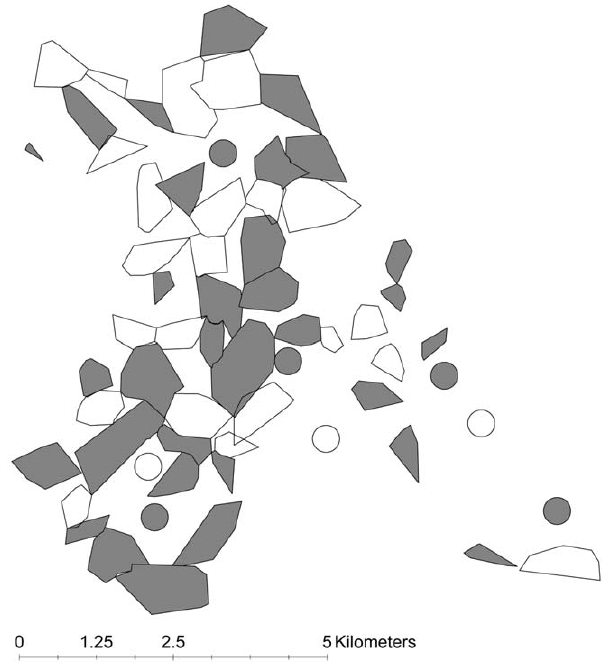
Figure 1. Configuration of badger social group territories in the first year of the study. Territories have been derived from bait marking data and show allocation of vaccine treatment (shaded areas) and control (open areas). Circles indicate additional main setts located after the 2006 bait marking for which the territorial boundaries could not be delineated until the following year, but which were determined to represent discrete social groups in 2006 and allocated a treatment accordingly. Additional badger groups may have been present in non- surveyed areas adjacent to the mapped territories, particularly around the edge of the study